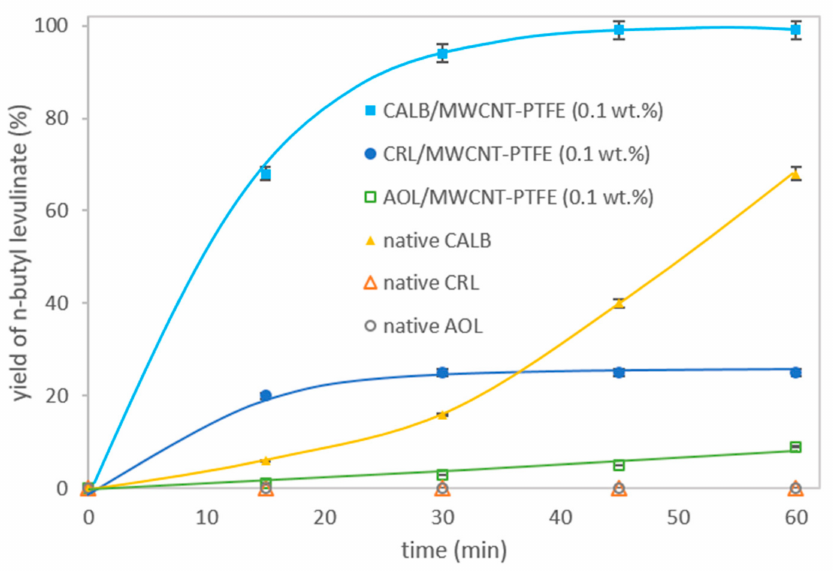
Figure 6. Comparison of native and immobilized lipases in LA esterification. Reaction conditions: LA (0.117 g, 1 mmol); n -butanol (0.148 g, 2 mmol); biocatalyst lipase/MWCNT-PTFE (0.10 wt.%) (150 mg) or native lipase 50 mg; cyclohexane (1 mL); 20 ◦ C; 250 rpm. CRL: lipase from Candida rugosa ; AOL: lipase from Aspergillus oryzae.